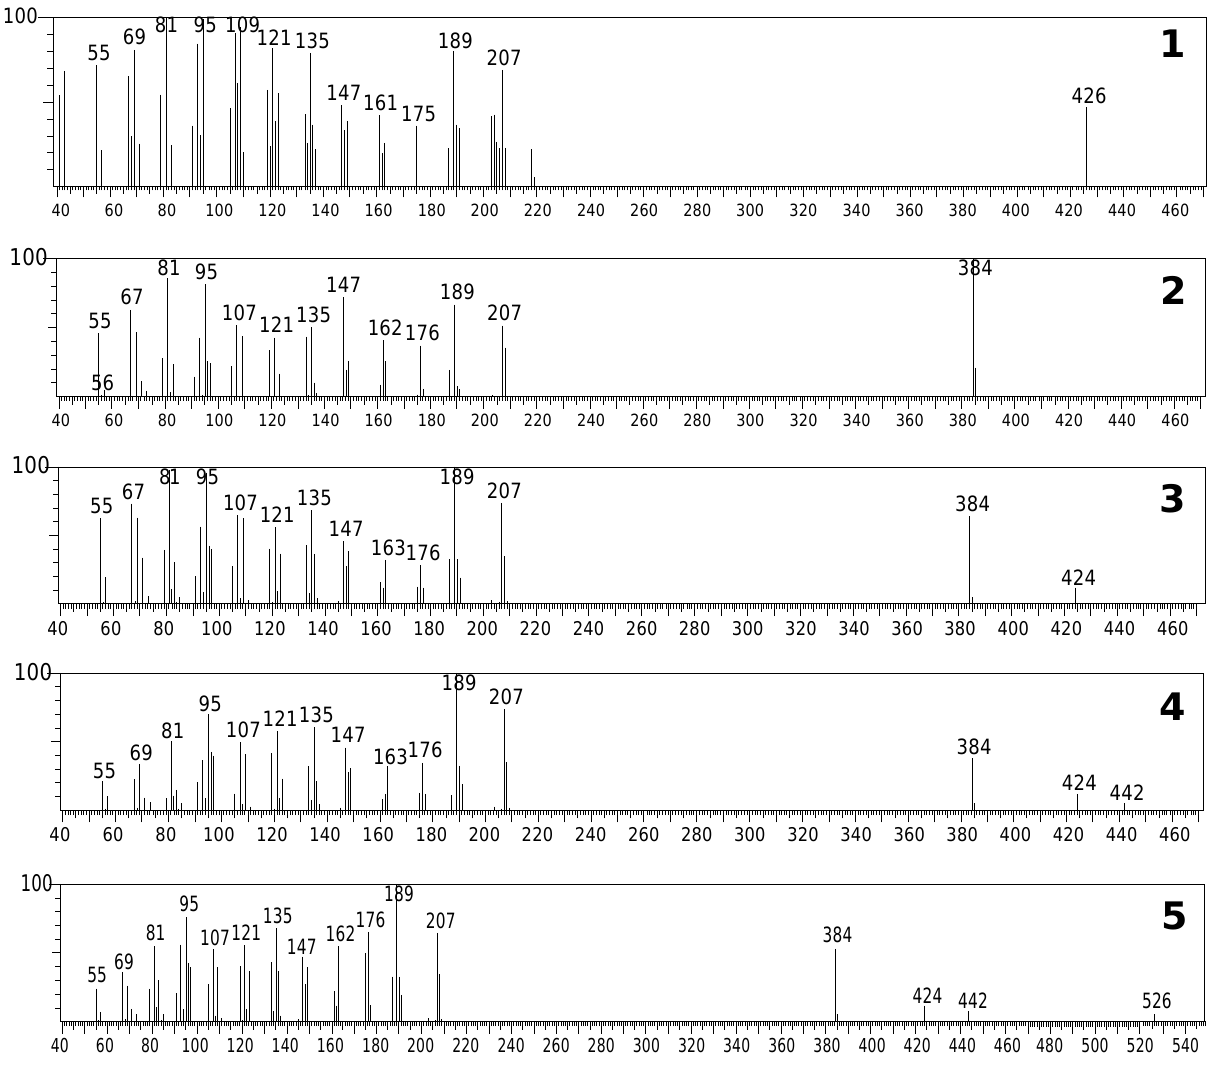
Figure 2. EI-MS spectra (35 eV) of lupeol ( 1 ) and its derivatives produced by A. ochraceus ( 2 and 3 , retention times of 46.5 min and 48.8 min, respectively), and by M. rouxxi ( 4 and 5 , retention times of 46.0 and 48.0